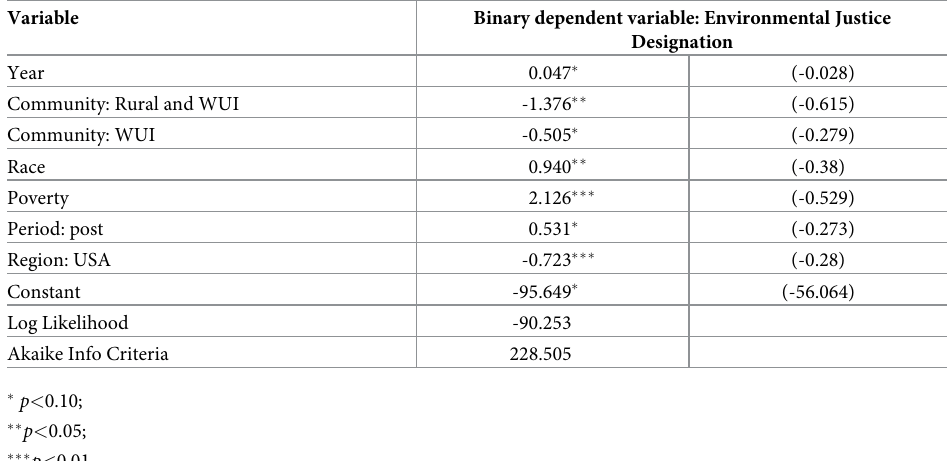
Table 2. Results of the probit model for variables significantly related to the classification of a publication as rele- vant to our definition of environmental justice (n = 299).